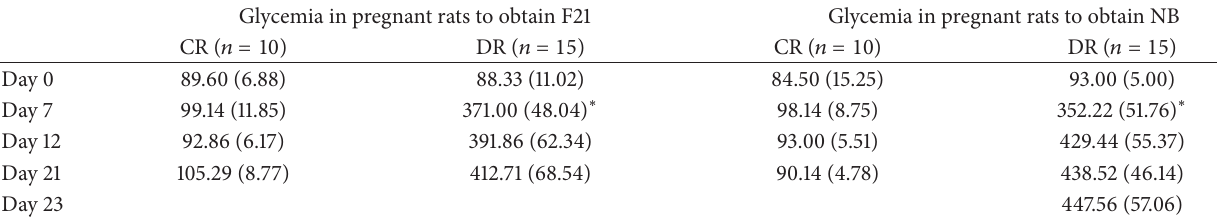
Table 2: Glycemia during pregnancy in mg/dL.